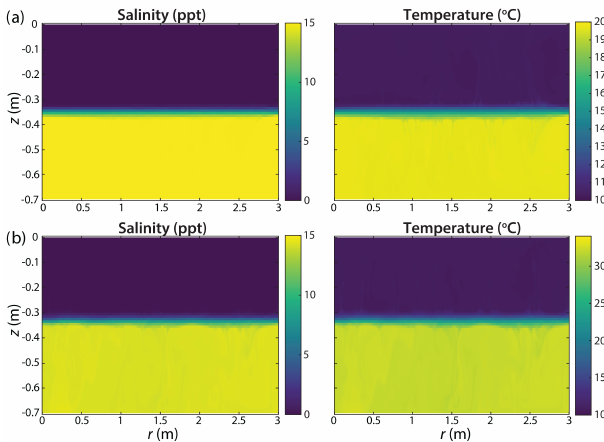
Figure 7. Double-diffusive convection in a layered system with a cold and fresh layer on top of warm and saline water ( t since the start), with density ratios of (a) R ρ (b) R ρ 0 . 50 (Case 2). All figures represent simulations without = the use of a turbulence